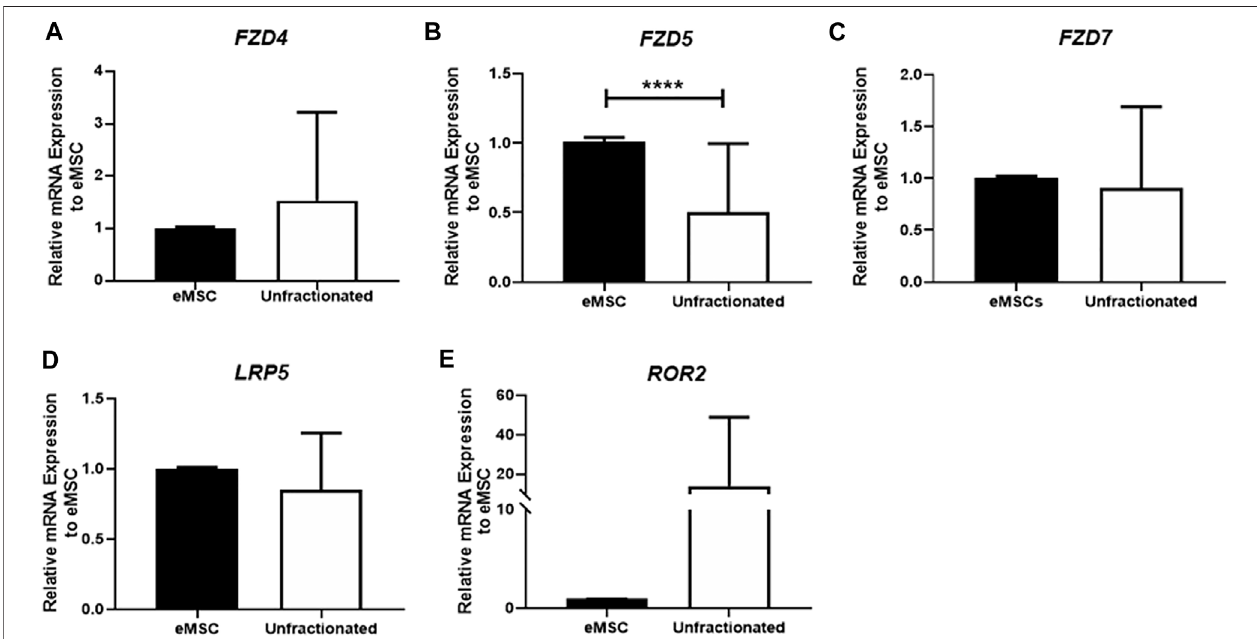
FIGURE1| GeneexpressionofFZDreceptorsinunfractionatedstromalcells,andeMSC.Therelativegeneexpressionof (A) FZD4 , (B) FZD5 , (C) FZD7 , (D) LRP5 , and (E) ROR2 in eMSC (black bars) and unfractionated stromal cells (white bars) normalized to 18 S (n = 21). Results are presented as mean ± SD; **** p <